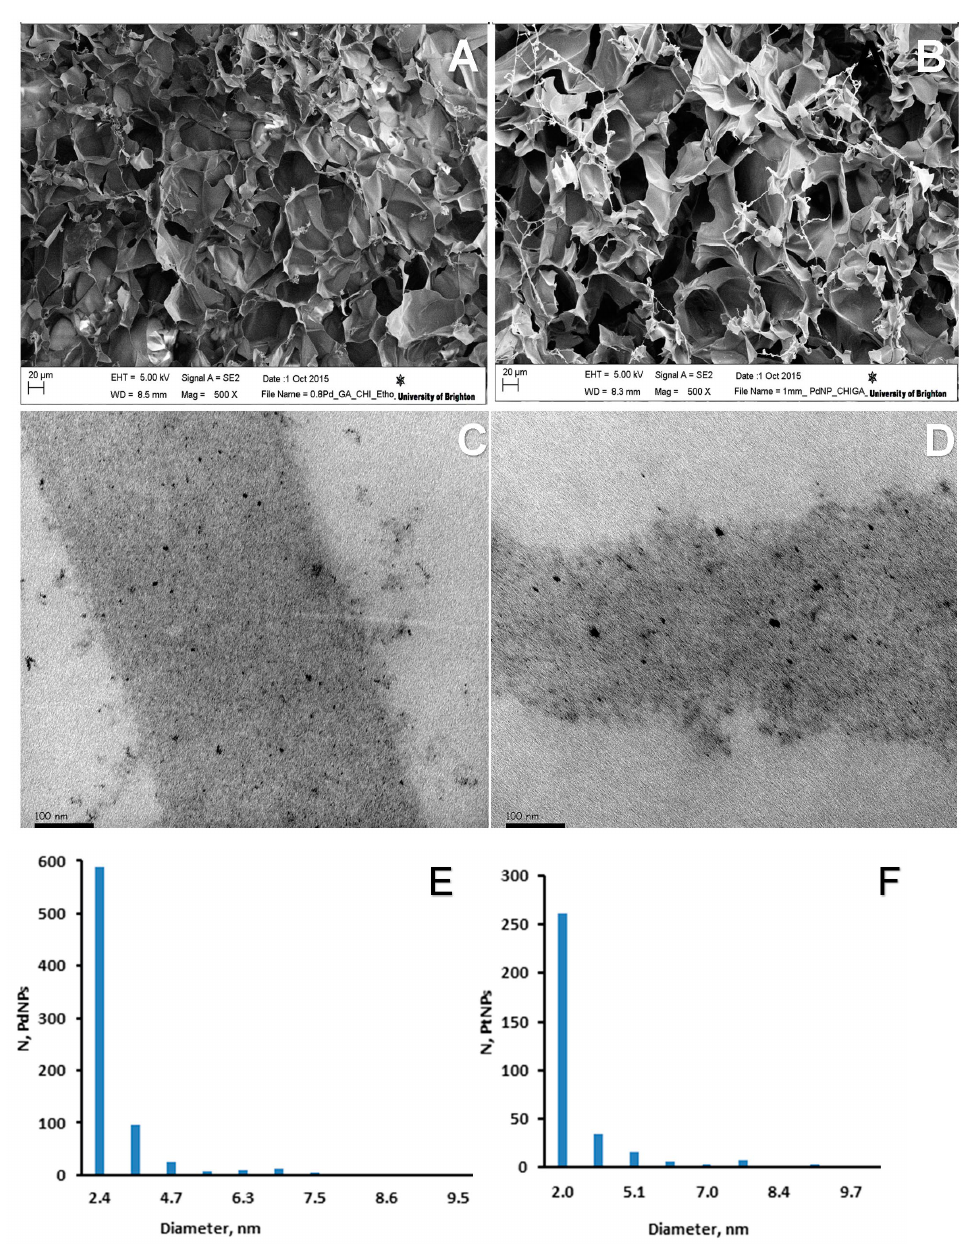
Figure 4. SEM images of CHI-GA-PdNPs cryogels: ( A ) 0.8 mM and ( B ) 1.0 mM; TEM images of cryogel walls: ( C ) CHI-GA-PdNPs 0.8 mM, ( D ) CHI-GA-PtNPs 4 mM; ( E ) PdNPs size distribution in CHI-GA-PdNPs 0.8 mM cryogel; ( F ) PtNPs size distribution in CHI-GA-PtNPs 4 mM cryogel.